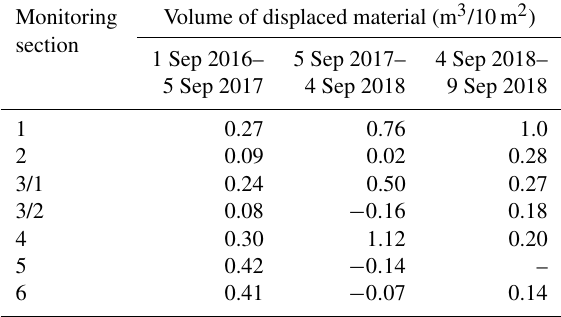
Table 2. Mean volumetric bank retreat rates for different monitor- ing intervals based on application of erosion pin